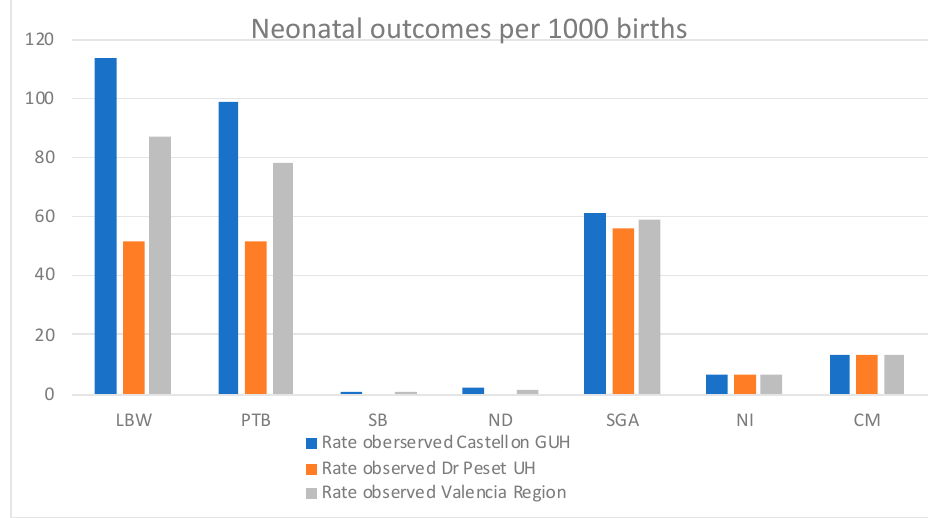
Figure 2. Incidence rates (per 1000 live births) for the different perinatal and neonatal outcomes identified, per study site and overall for the Valencia Region.